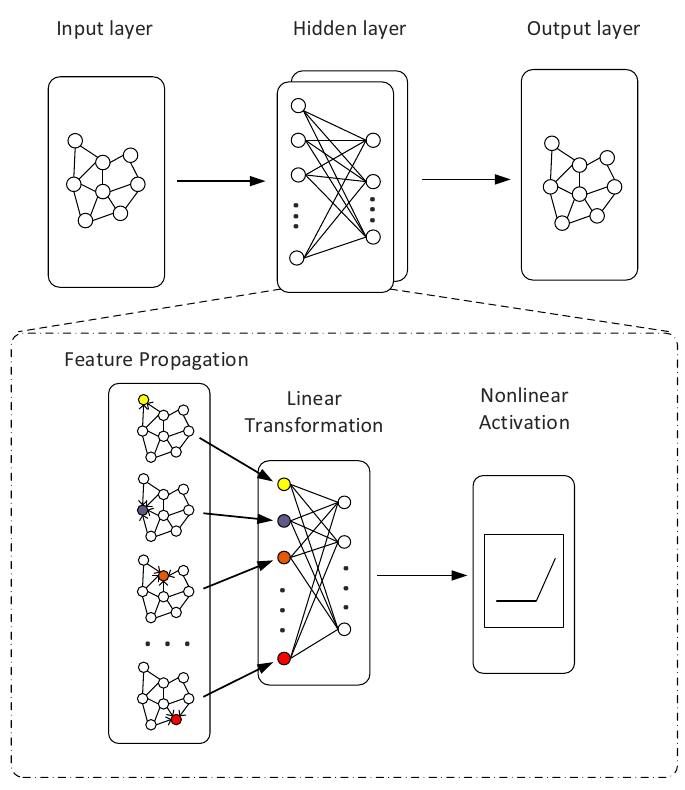
Figure 3. The principle of the 2-layer GCN. Diagram of GCN updating rule for hidden layer in the virtual